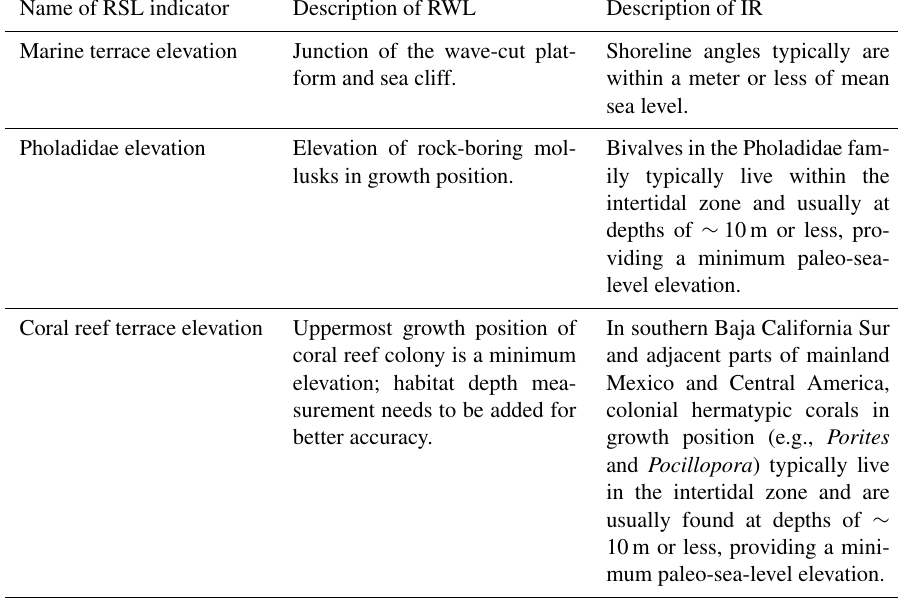
Table 1. Different types of RSL indicators: reference water level (RWL) and indicative range (IR) on the Pacific coast of North America. Name of RSL indicator Description of RWL Description of IR Marine terrace elevation Junction of the wave-cut plat- Shoreline angles typically are form and sea cliff. within a meter or less of mean sea level. Pholadidae elevation Elevation of rock-boring mol- Bivalves in the Pholadidae fam- lusks in growth position. ily typically live within the intertidal zone and usually at depths of ∼ 10m or less, pro- viding a minimum paleo-sea- level elevation. In southern Baja California Sur Coral reef terrace elevation Uppermost growth position of and adjacent parts of mainland coral reef colony is a minimum Mexico and Central America, elevation; habitat depth mea- colonial hermatypic corals in surement needs to be added for growth position (e.g., Porites better accuracy. and Pocillopora ) typically live in the intertidal zone and are usually found at depths of ∼ 10m or less, providing a